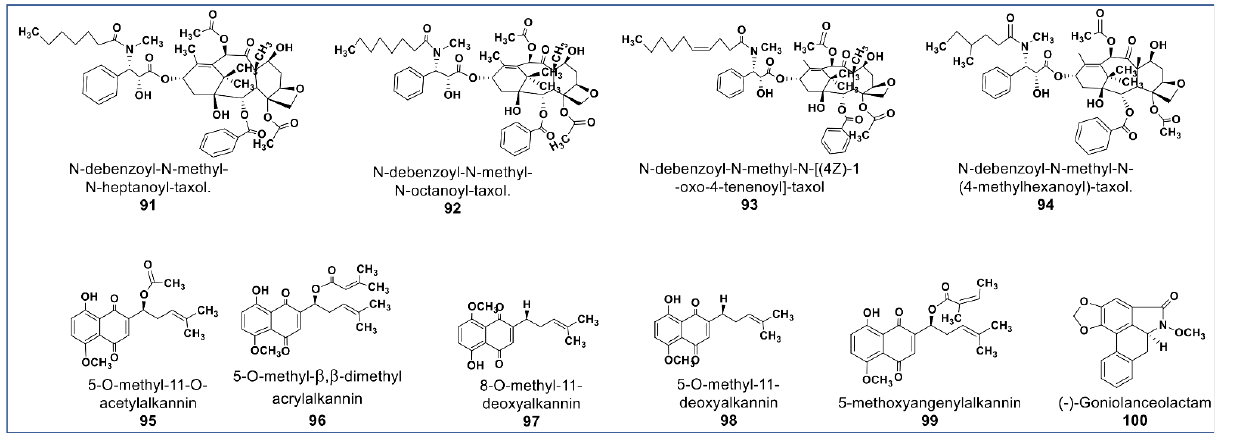
Figure 7. Representative members of new alkaloid phytochemicals from various plant sources (compounds 91 to 100 ).